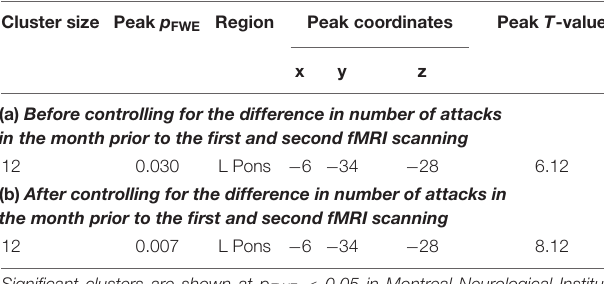
TABLE 3 | Regions of interest (ROI) analysis in migraine-related regions: dorsal pons showing a significantly decreased activation in response to fearful emotional stimuli after autogenic training (AT) completion in